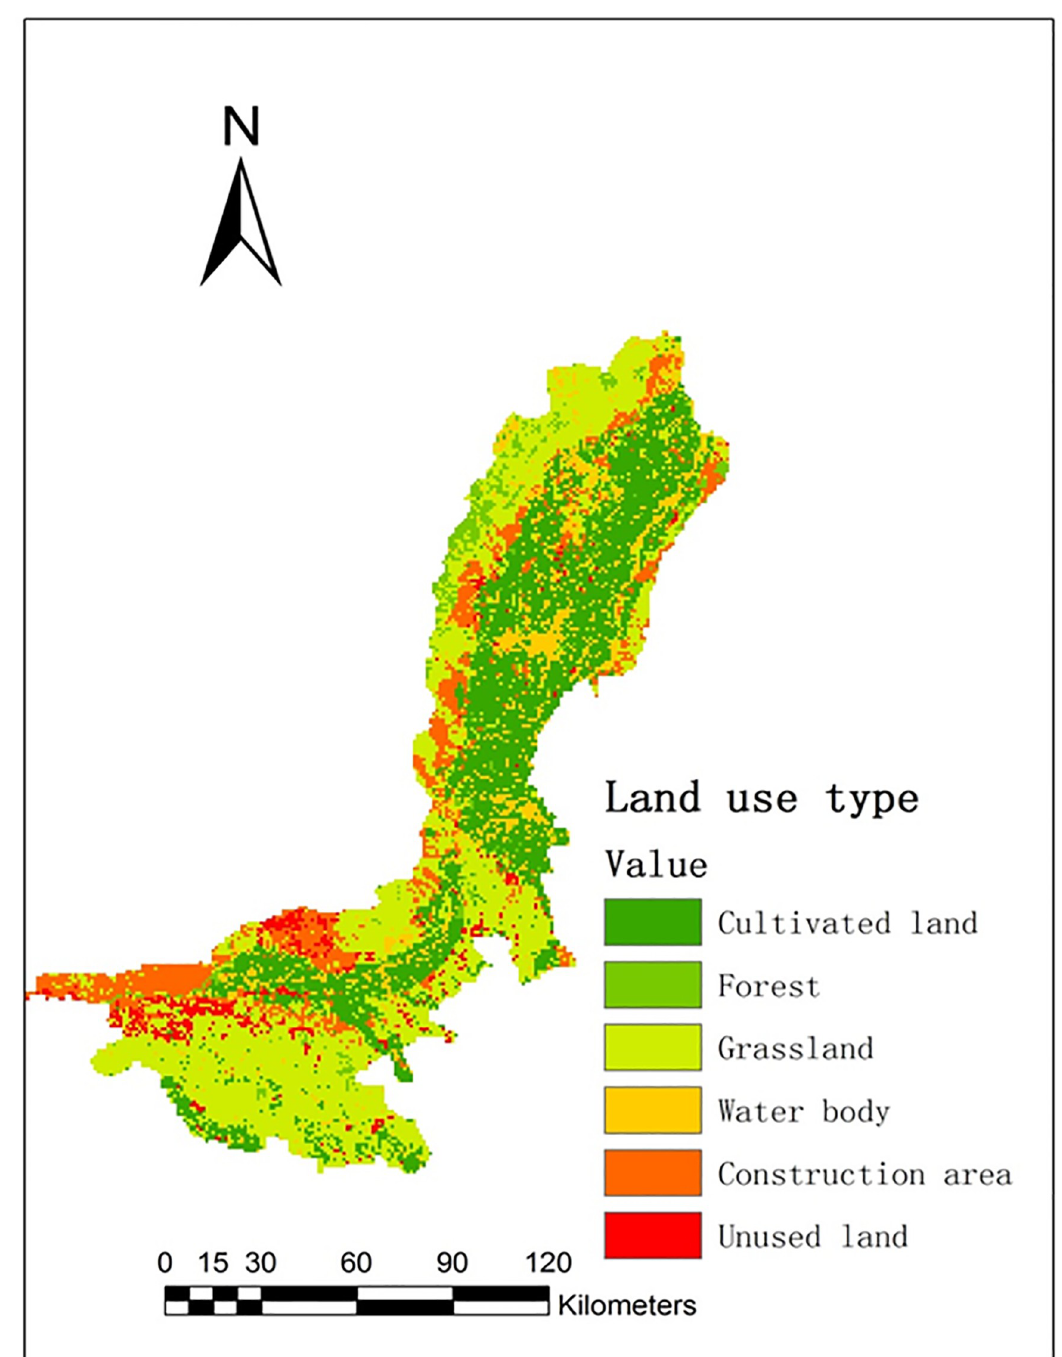
Fig 2. Land use map of Ningxia Yellow River irrigation region in 2004.